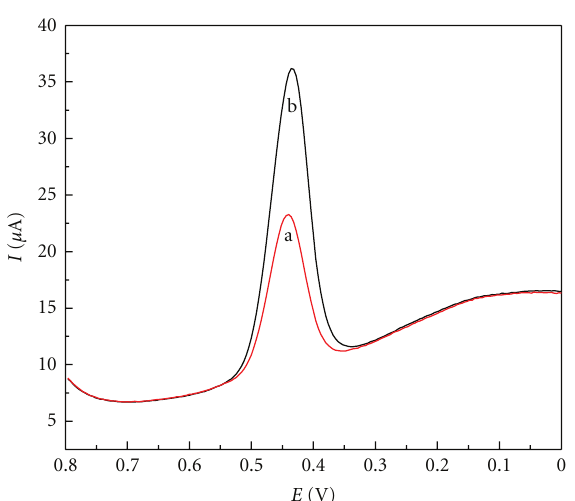
Figure 6: Typical CVs of (a) rutin sample (containing 2.6 µ g Rutin) and (b) a was spiked with 2.6 µ g rutin in 5mL 0.1 M pH 5.0 phosphate bu ff er